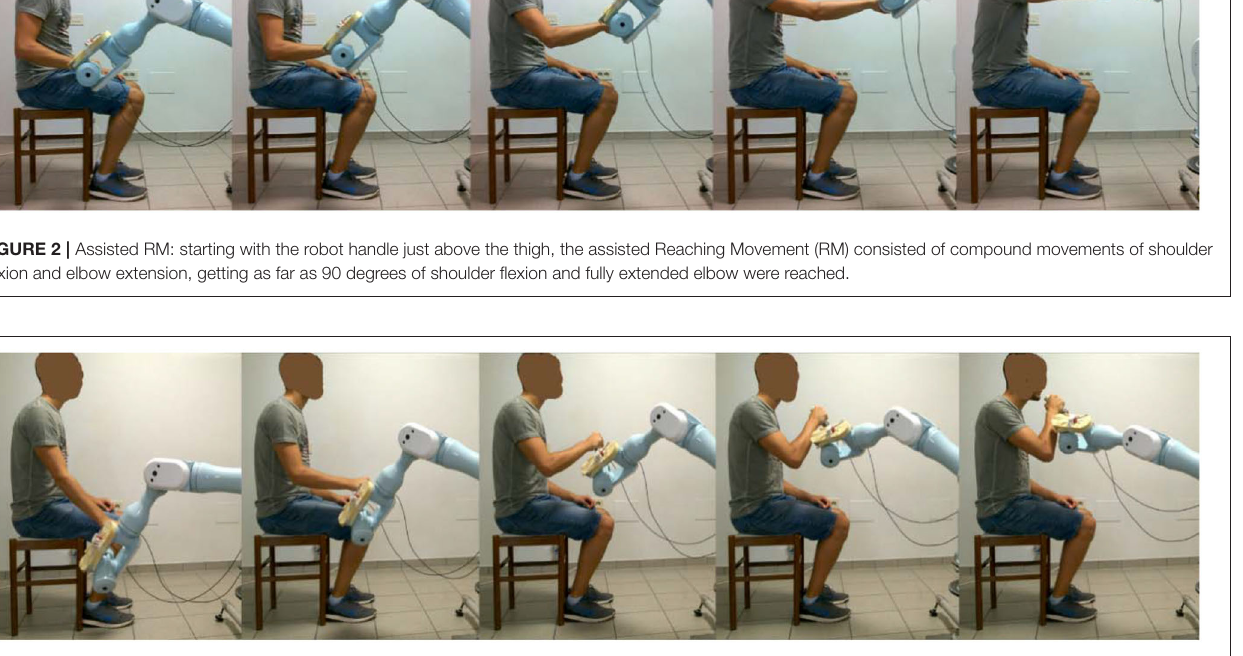
FIGURE 3 | Assisted Hand-to-Mouth Movement (HtMM): Starting with the robot handle just above the thigh, the assisted HtMM consisted in flexing the elbow (and the shoulder) to position the robot-handle in front of the mouth. Importantly, the handle was free to rotate and, therefore, the patient had to put it actively (performing wrist internal/external rotation movements) in the right position, which was with its extremity pointing toward the